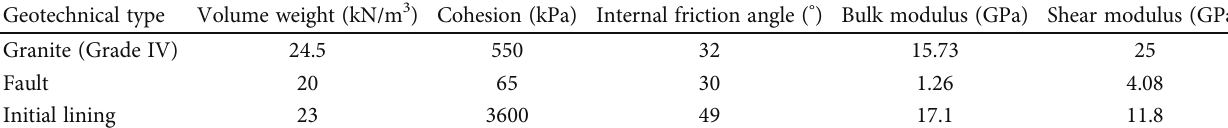
Table 1: Geotechnical parameters of the numerical model.